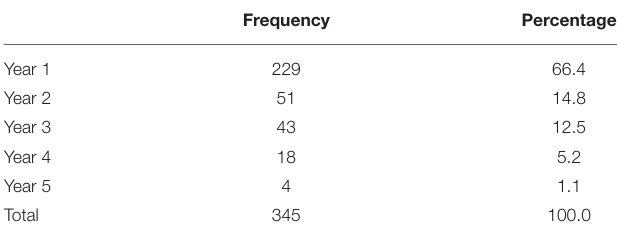
TABLE 6 | The classification of the understanding of synchronous and asynchronous online learning mode among the staff.